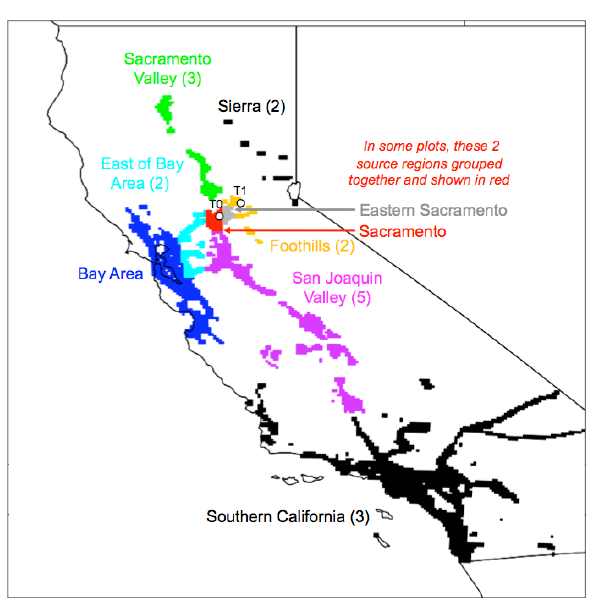
Figure 2. Spatial distribution of the CO tracer source regions employed by the operational WRF-Chem 958 Fig. 2. Spatial distribution of the CO tracer source regions em- forecasts during CARES. A total of 20 source regions were defined, but colors denote larger geographic 959 source regions used in subsequent plots, where the parentheses indicates the number of source regions 960 ployed by the operational WRF-Chem forecasts during CARES. A grouped together per color. 961 total of 20 source regions were defined, but colors denote larger ge- ographic source regions used in subsequent plots, where the paren- theses indicates the number of source regions grouped together per